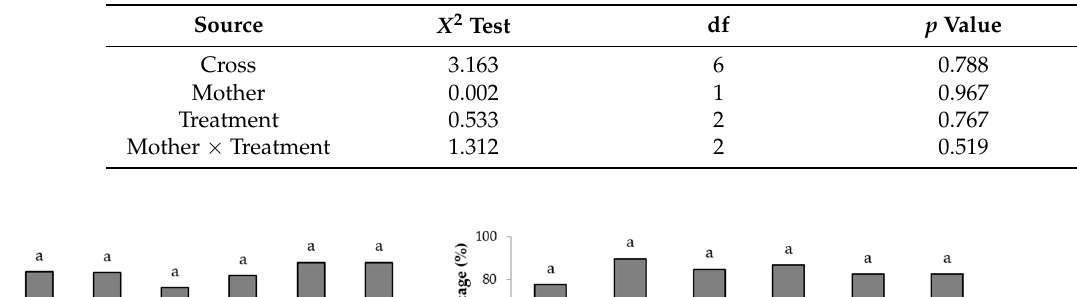
Table 4. Analysis of deviance of the mixed logistic regression for germination (%) according to cross, mother tree, treatment and their interaction.